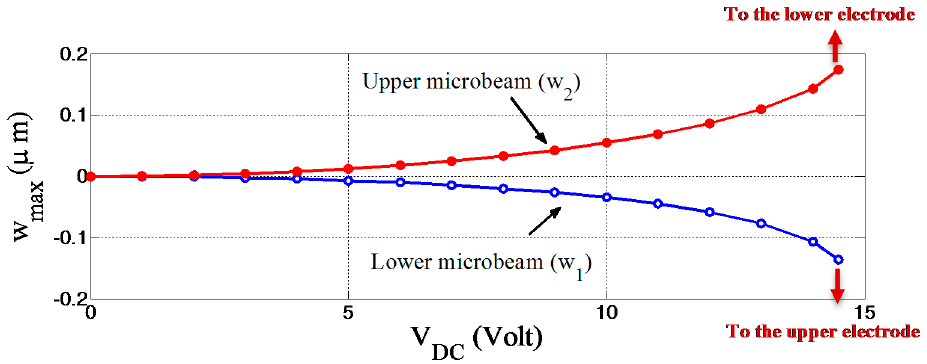
Figure 4. Variation of the maximum static deflection with the DC voltage for the lower and upper microbeams and for the case when d 1 > d 2 .